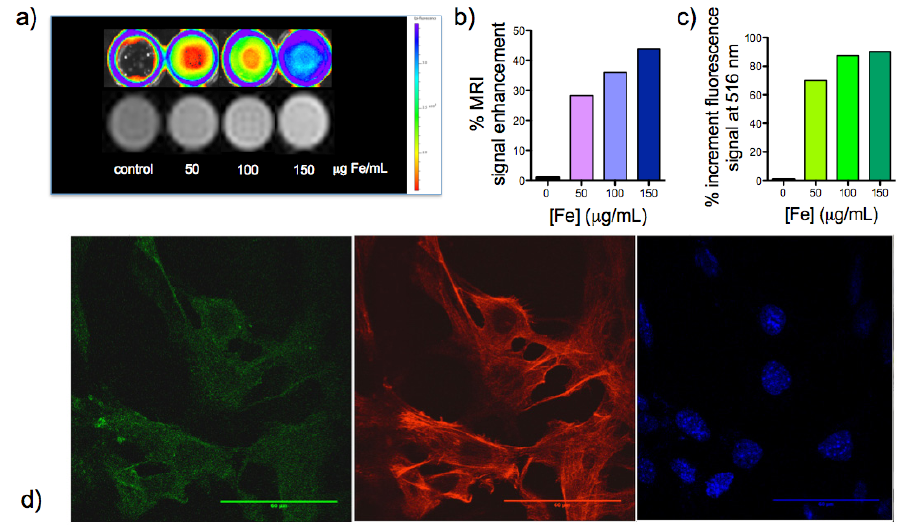
Figure 2. ( a ) Fluorescent imaging and magnetic resonance imaging (MRI) of labeled MAFs cells with fdIONP; ( b ) Percentage of signal enhancement in magnetic resonance images of labeled MAFs cells; ( c ) Percentage of signal enhancement in fluorescence images of labeled MAFs cells; and ( d ) Fluorescent confocal images of fdIONP-labeled cells at 80 µg/mL Fe concentration after 24 h of incubation, signal from fdIONP (green), phalloidin dye (red), and DAPI